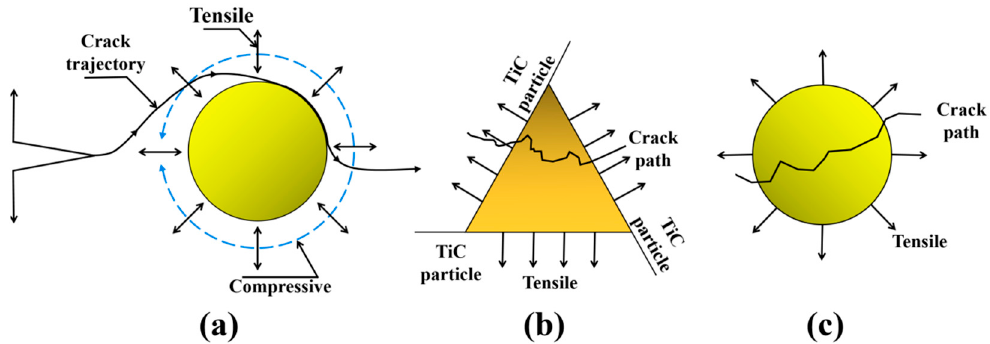
Figure 8. ( a ) Mechanism of crack deflection, ( b ) Fracture mode of grain boundary phase, ( c ) Transgranular fracture mode.